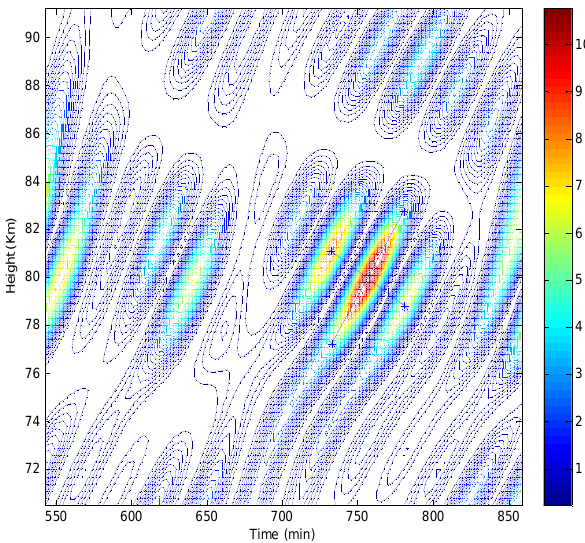
Fig. 9. A partial range-time plot of (δV ) 2 of meridional velocity converted from dataset observed by the MU radar at Shigaraki Japan on 15 November 1988. Determination of vertical phase and group velocities of wave packets were indicated by the phase lines (along the patch) and energy lines (across the patch).